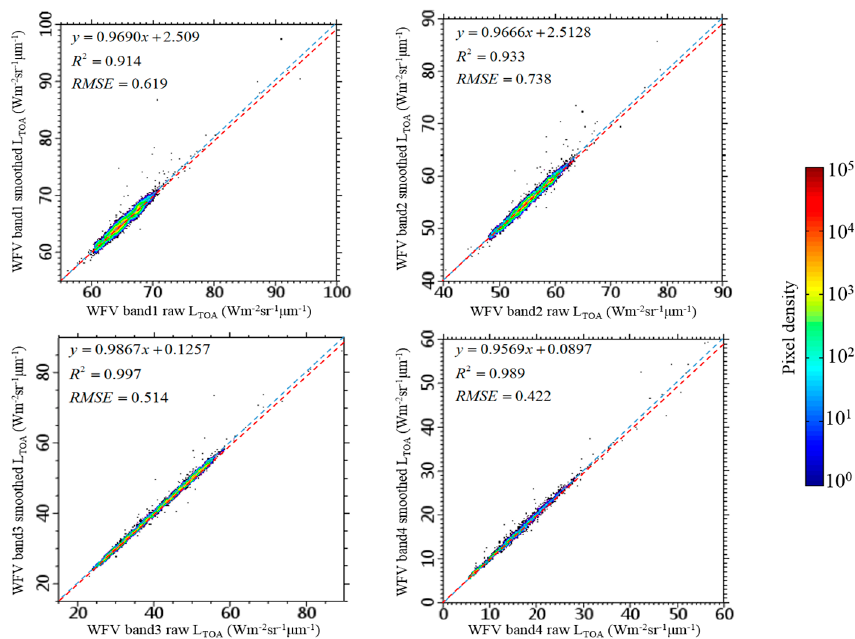
Figure 7. Comparison between raw (x-axis) and smoothed (y-axis) WFV L TOA of corresponding pixels ( N = 4,465,514) at each band. Pixels are within region-of-interests for sampling (three dashed black box in Figure 4a). Colors denote pixel densities, the dashed red line is the regression line and the dashed blue line is the 1:1 line.